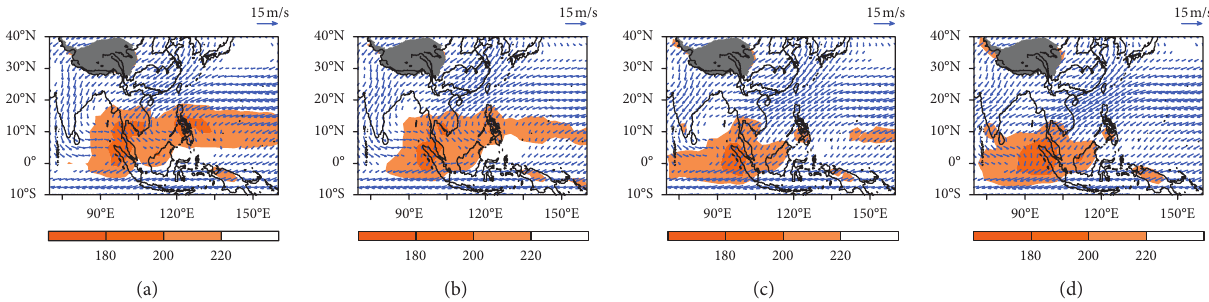
Figure 6: Composite evolution of OLR (W/m 2 , shadings) and 850 hPa wind (m/s, vectors) based on the SCSSM withdrawal date from (a) two pentads before the monsoon withdrawal ( P − 2), (b) one pentad before the monsoon withdrawal ( P − 1), (c) during the monsoon withdrawal ( P 0), and (d) one pentad after the monsoon withdrawal ( P + 1) for the period of